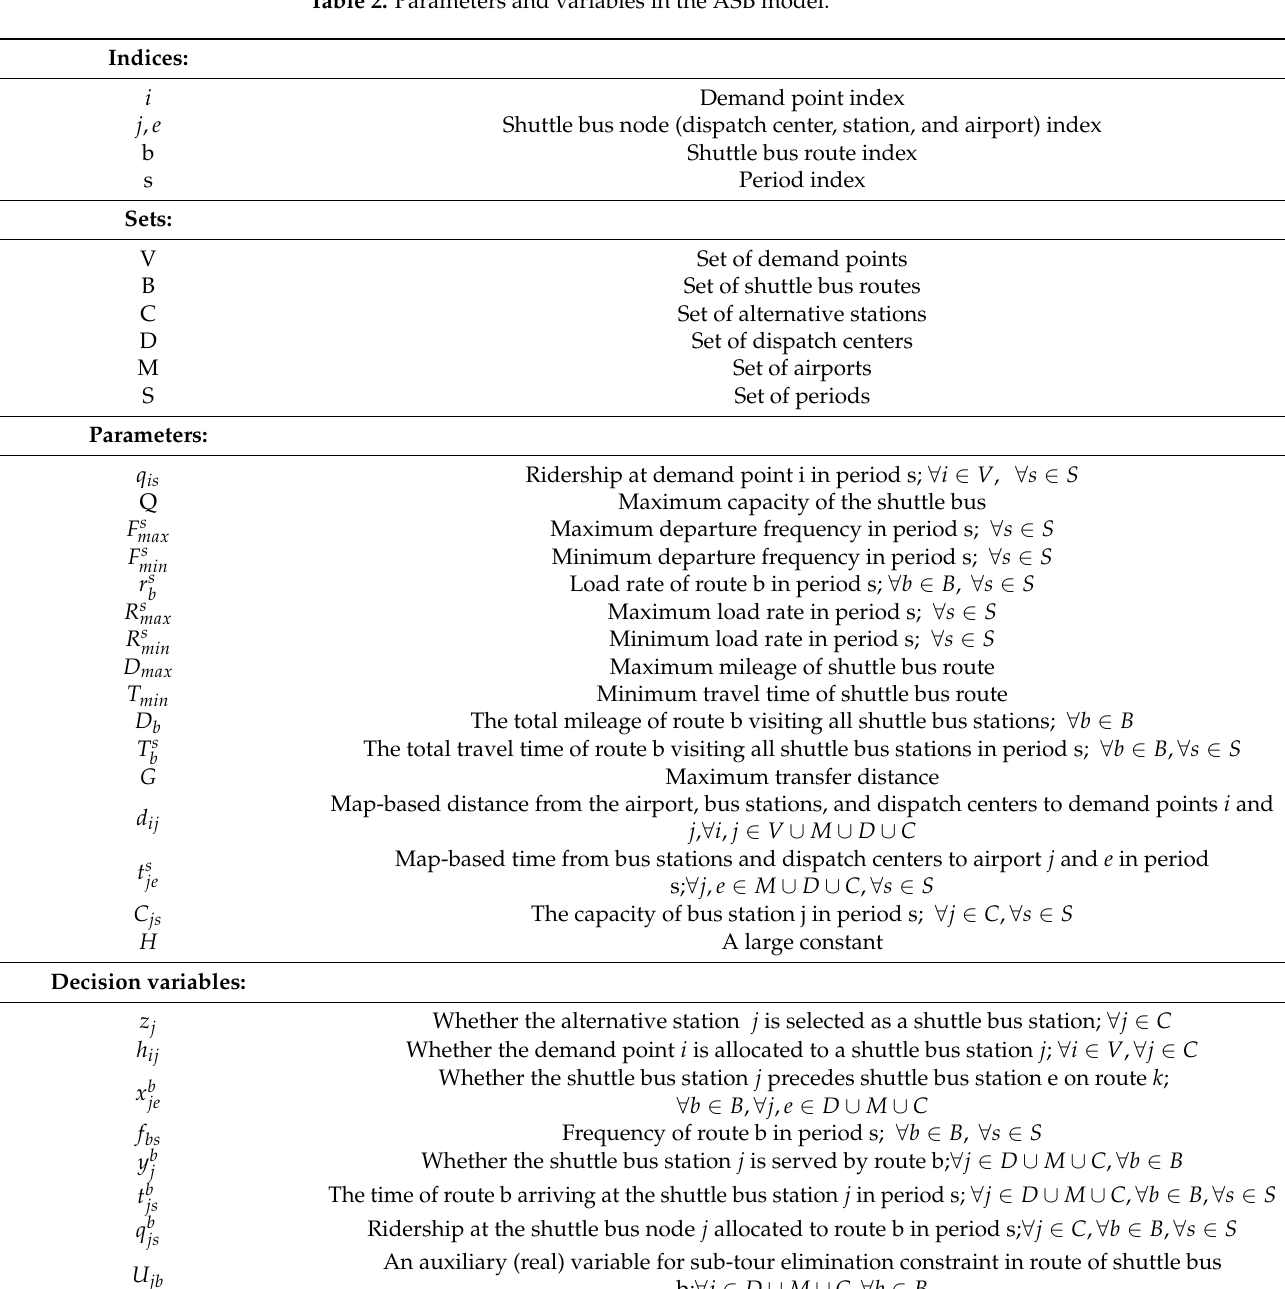
Table 2. Parameters and variables in the ASB